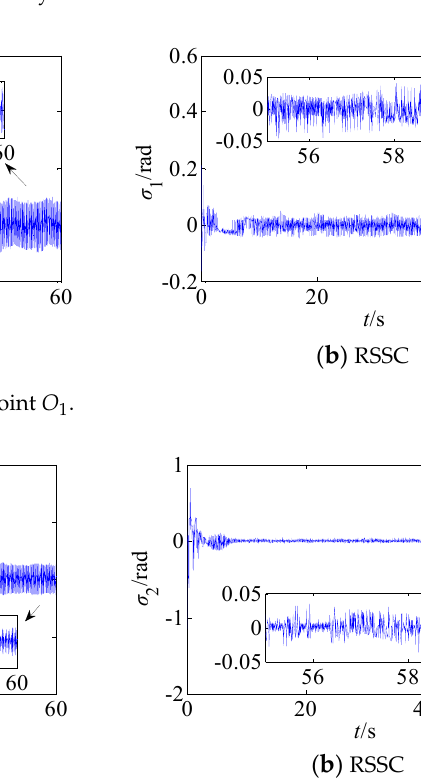
Figure 7. Elastic vibration curve of joint